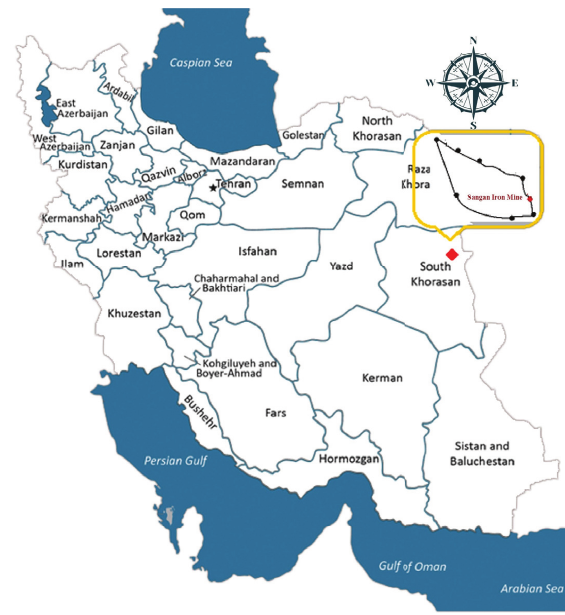
Figure 4: The location of Sangan iron mine